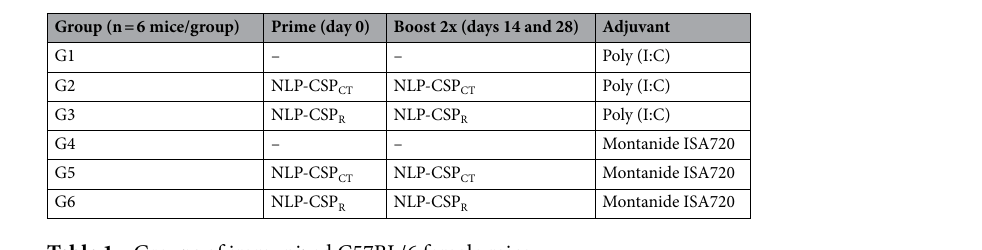
Table 1. Groups of immunized C57BL/6 female mice.